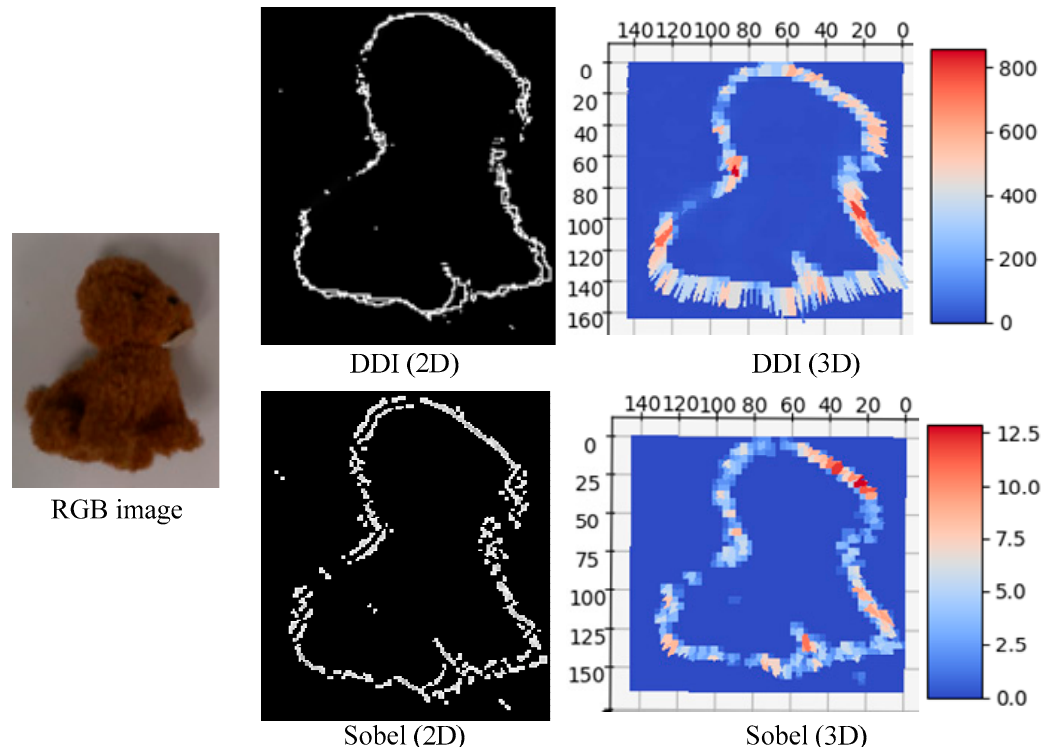
Figure 5. DDI and result of the Sobel operator in two and three dimensions.